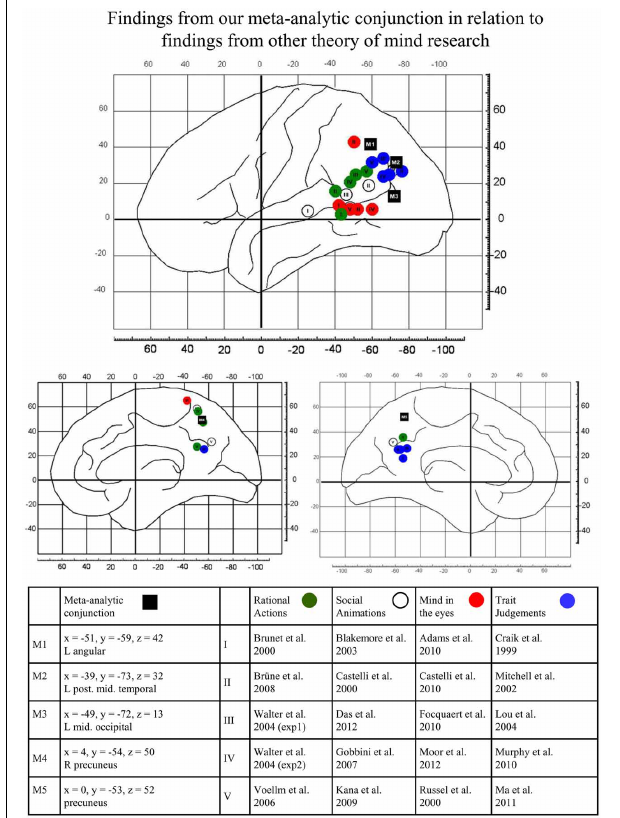
FIGURE 2 | Graphical illustration of the relations between the findings from our meta-analytic conjunction (black full rectangles) and findings reported in other theory of mind research. Activation peaks reported in original studies are separately shown for tasks presenting rational actions (green full circles), social animations (white full circles), mind in the eyes (red full circles) and trait judgments (blue full circles). For details, see